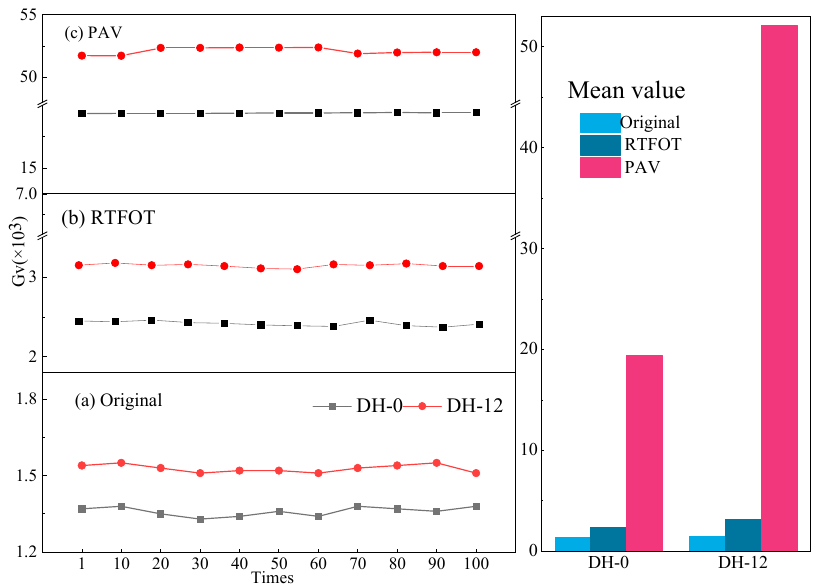
Figure 7. The viscous component G v of the Donghai 90# binder and the lignin-modified binder. ( a – c ) creep test viscosity component representing as is, short-term aging and long-term aging.